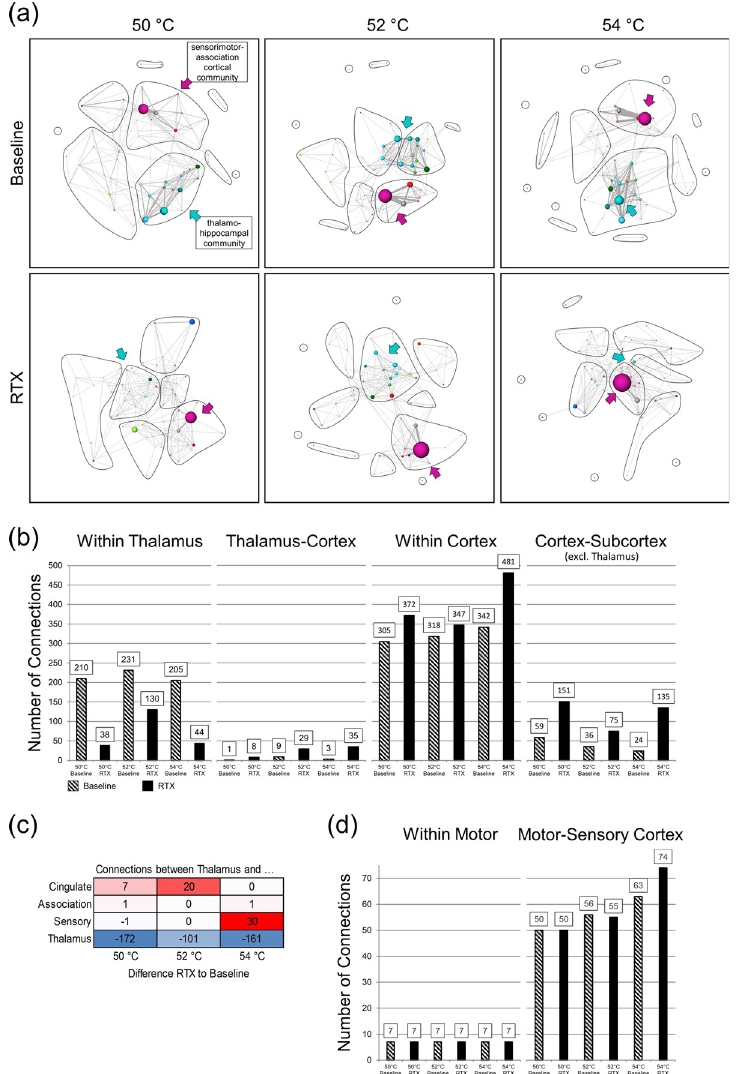
Fig 6. Stimulus-driven Blondel communities proofed that both affected subnetworks were an interconnected system. (a) RTX administration repressed mainly intra-thalamic connections (size of light blue nodes massively decreased, RTX) within the thalamo-hippocampal community (blue arrows) but enhanced the number of cortical connections (size of pink nodes increased, RTX) within the sensorimotor-association cortex community (pink arrows). Different functional groups are distinguished by the node colors (see legend in Fig 5), the size of the node represents the node degree (number of connections one functional group has to each other and also within the group). Edge thickness represents FC between two functional groups. Black lines encircle the Blondel communities. (b) RTX (solid) compared to baseline (shaded) reduced effectively the number of intra-thalamic (also see (c)) but increased all higher order connections, i.e. thalamo-cortical, within cortex as well as cortical-subcortical (excluding thalamus) connections. These can be observed for all stimulation temperatures, shown in the graphic are data from 50˚C to 54˚C. (c) Especially the number of connections between thalamus and cingulate cortex was increased for temperatures below 54˚C whereas above 54˚C no difference was found for thalamic-cingulate connectivity but instead connectivity between thalamus and sensory cortex increased. Shown is the difference between RTX and baseline for the number of connections between thalamus and the denoted regions. Marked in red are connections that were increased by RTX, blue are connections that were decreased by RTX. (d) Example of connections that are independent of RTX- administration: motoric output regions (comprising motor cortex and cerebellum) displayed stable connections within as well as to somatosensory cortex. (n Baseline = 18; n RTX =